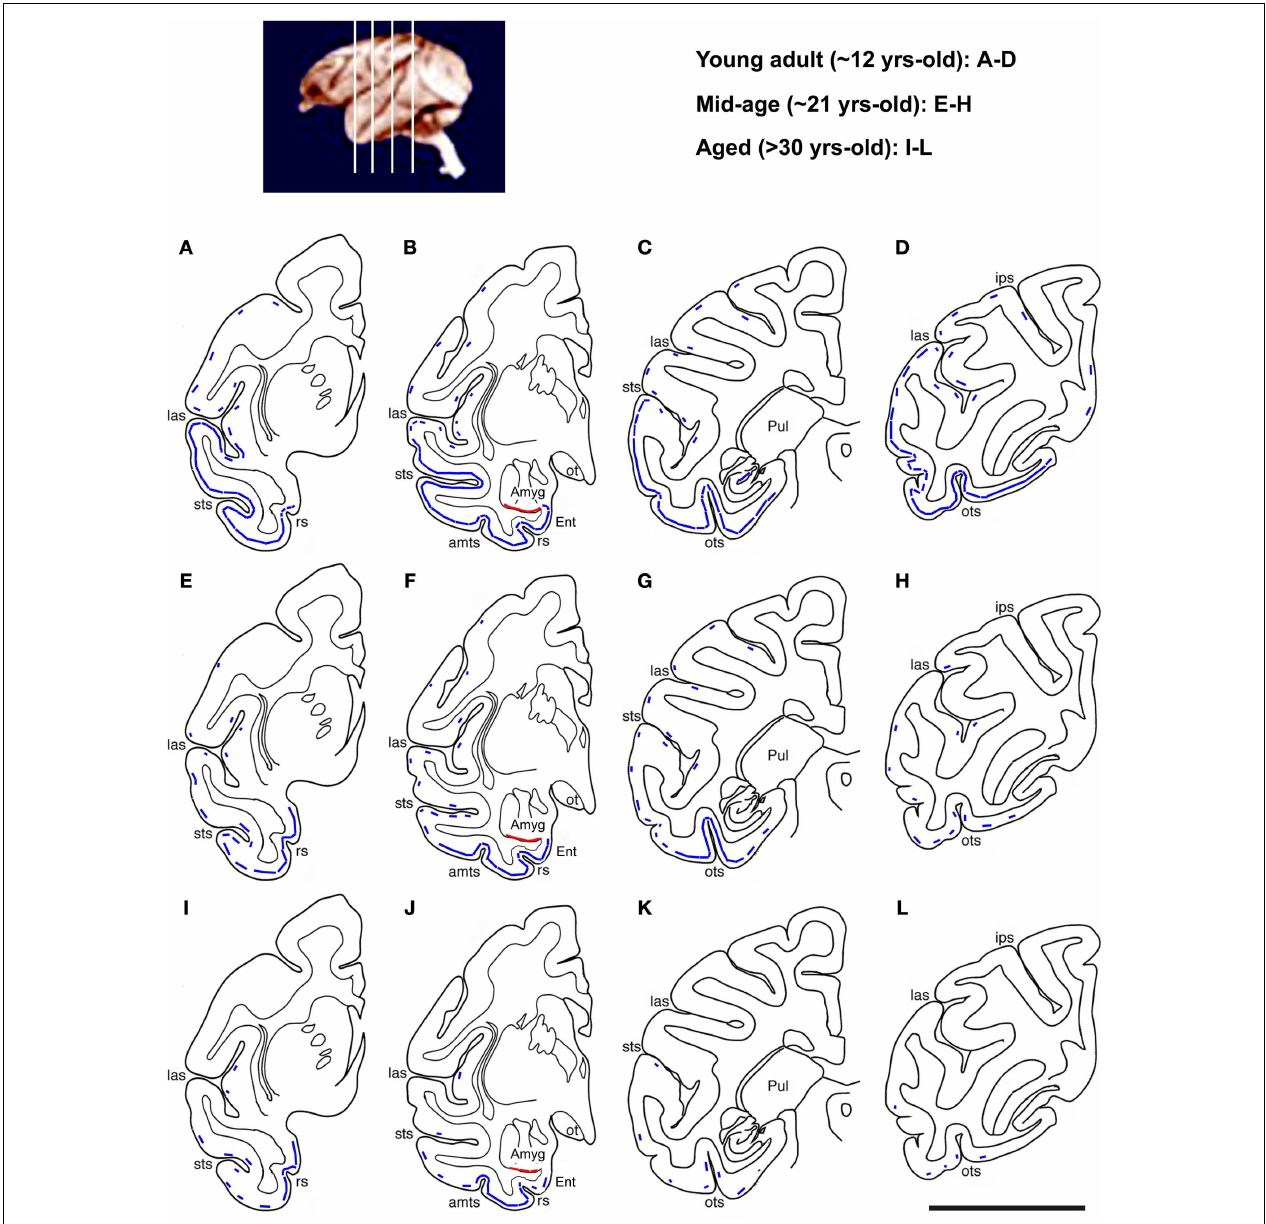
FIGURE 4 | Schematic drawings illustrating an overview of age-related change in DCX + cell distribution in the temporoparietal cortical areas at four representative anterioposterior frontal levels as indicated in the top- left map. In the young adult group (A–D) , DCX + cortical cells occur in layers II/III as a continuous cellular band (blue line) extending ventrally from the entorhinal cortex (Ent) to laterally all of the temporal neocortical areas. There follows a parallel decline in the abundance of labeled cells along this band with age (E–L) . Thus, the cellular band “retracts” dorsoventrally to become impressive only in